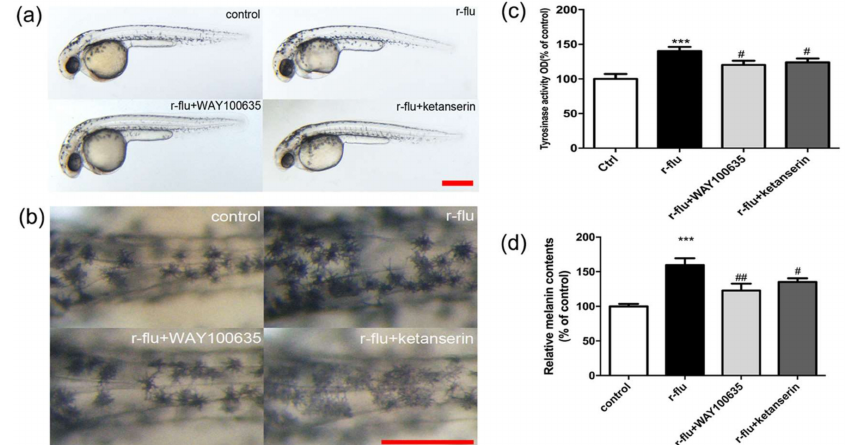
Figure 6. Effect of the WAY100635 and the ketanserin on the melanin contents in the r-fluoxetine-induced zebrafish pigmentation. Synchronized embryos were treated with r-flu (100 µ m), WAY100635 (10 µ M), and ketanserin (10 µ M), at 6 hpf and incubated for further 30 hpf. The effect on the pigmentation of the zebrafish were photographed under the stereomicroscope. ( a ) Lateral view of embryos at 36 hpf, ( b ) dorsal view of embryos at 36 hpf. Scale bar, 200 µ m. ( c ) Tyrosinase activity and ( d ) melanin contents were performed, as described in the Materials and Methods section. Data were analyzed by a one-way analysis of variance (ANOVA) followed by post hoc Tukey test. Bars indicate the means ± SEM of the three independent experiments. *** p < 0.001, compared with the control; # p < 0.05, ## p < 0.01, compared with r-flu